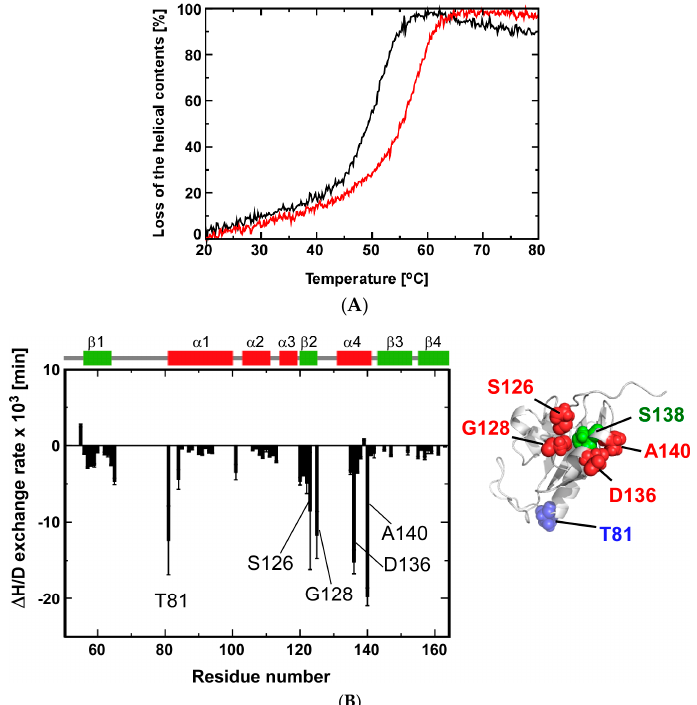
Figure 2. Comparison of the thermal stability and backbone amide H/D exchange rates of the wild-type [13] and S138A mutant proteins. ( A ) Thermal melting profile of the wild-type Pin1-PPIase (black) and the S138A mutant (red) by measuring the CD ellipticity at 222 nm. The definition for the loss of helical content is described in Section 4.2; ( B ) Differences in H/D exchange rates between the wild-type and the S138A mutant: the difference in H/D rate ( Δ H/D rate) for each residue was obtained as Δ H/D rate = H/D rate (S138A) − H/D rate (wild-type). Only the Δ H/D rates greater than the error rages are plot. Residues without exchange rates showed no observable peaks in the first 2D 1 H– 15 N HSQC spectrum recorded in the data series collected, implying their amide protons have rapidly exchanged to deuterons within ~ 10 min. Residues with reduced backbone amide H/D exchange rates in S138A are labeled. These residues near the mutation site are mapped onto the wild-type Pin1-PPIase structure as red spheres and S138 is indicated by the green sphere. The reduced amide H/D exchange rate was also found for T81 in α 1, which residue is marked by blue spheres on the structure.